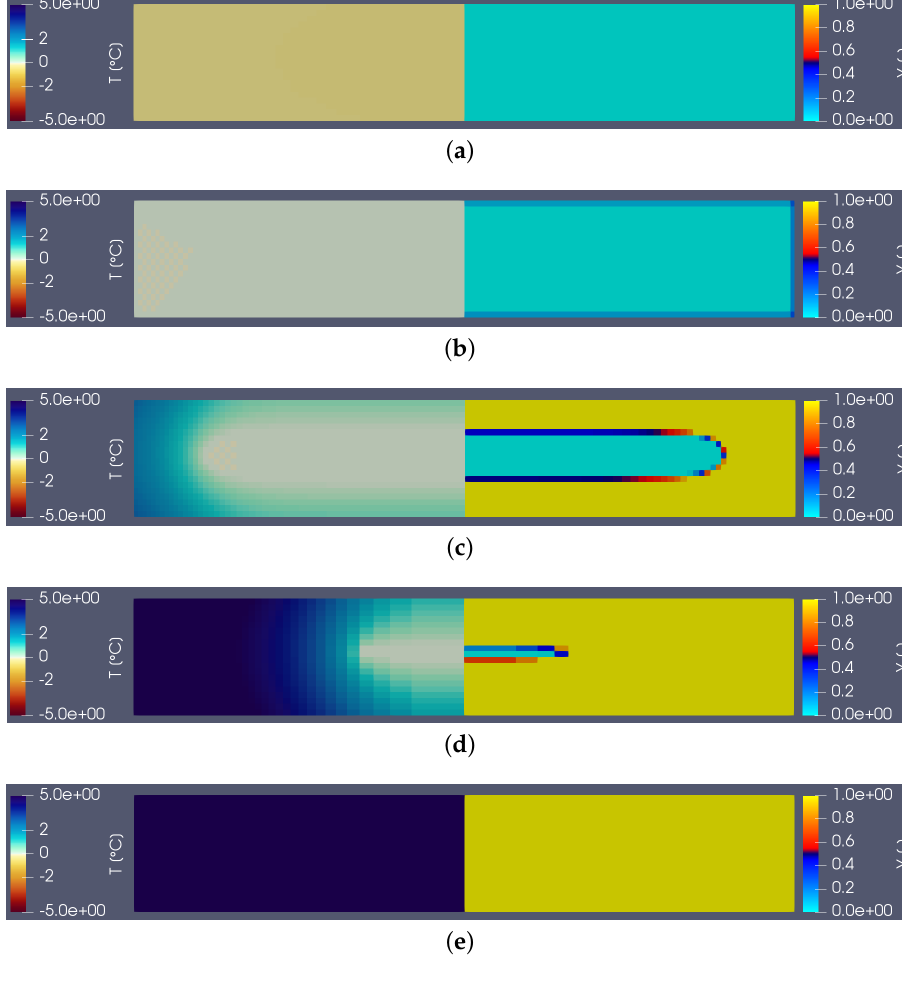
Figure 3. Key evolution steps during fusion (Water, 5K/min). ( a ) Solid state; ( b ) Start of the fusion; ( c ) Maximum flux; ( d ) End of the fusion; ( e ) Back to